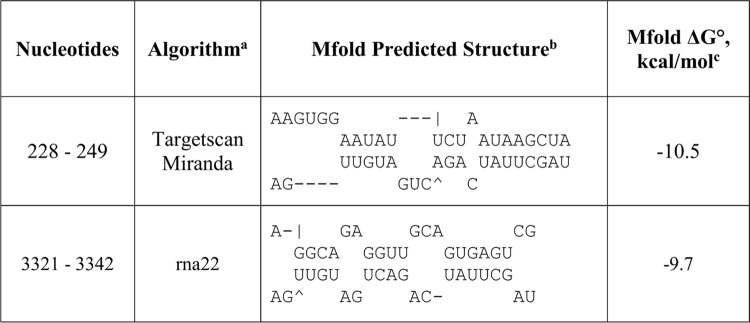
Predicted miR-21-5p guide strand binding sites in the 3'UTR of PDCD4 mRNA.
aThe potential oncomiR:mRNA binding sites were identified by rna22, Targetscan, or miRanda. bTop strand is mRNA (5' ➔ 3') and the bottom strand is oncomiR (3' ➔ 5'). cCalculated at http://mfold.rna.albany.edu/?q=mfold.